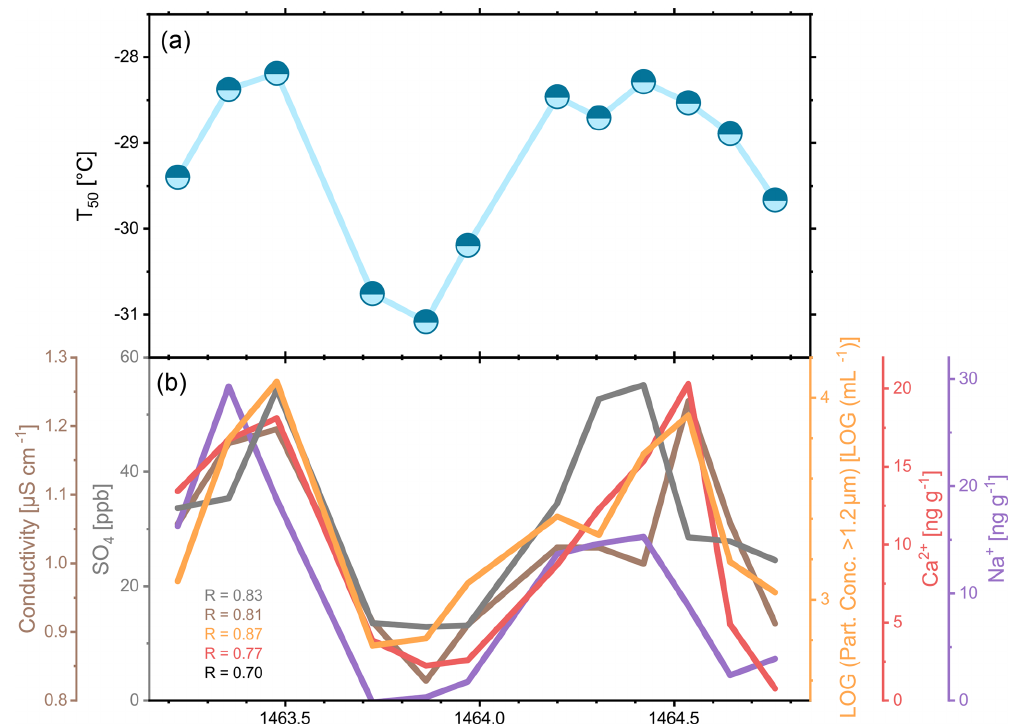
Figure 11. (a) Nucleation temperature at which 50% of the droplets were frozen during a high-resolution period around 1464 (sample resolution: 1–2 months). (b) Corresponding average concentration of IC (SO 2 − ) and CFA (conductivity, insoluble particles, Ca 2 + , and 4 Na + ) parameters. Pearson coefficients for correlation of parameters to INP concentration are indicated (all p< 0.05). Please note that the x axis may entail some temporal offset, as they refer to individual analyses performed separately on the core which may differ in their depth assignment by